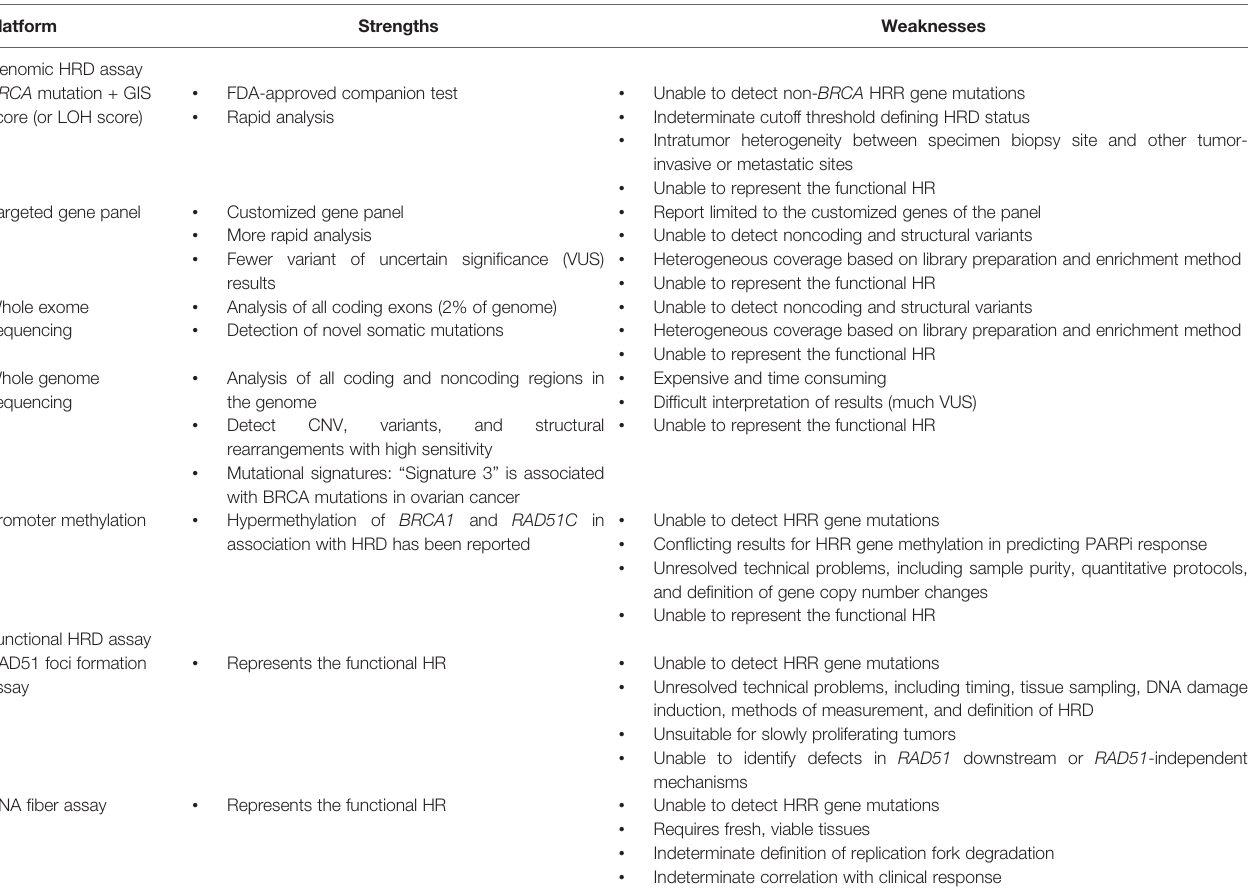
TABLE 5 | Main strengths and weaknesses of the HRD assays.